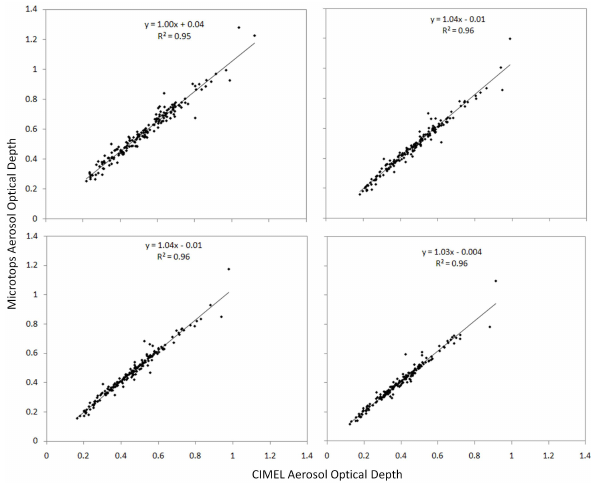
Fig. 2. Inter-comparison of co-located measurements of Aerosol Optical Depth from automatic and handheld sunphotometers over Jaipur. Scatter plots show the entire set of all temporally co-located instantaneous retrievals within ± 15mn from the two instruments at four wavelengths namely, 340nm, 440nm, 500nm and